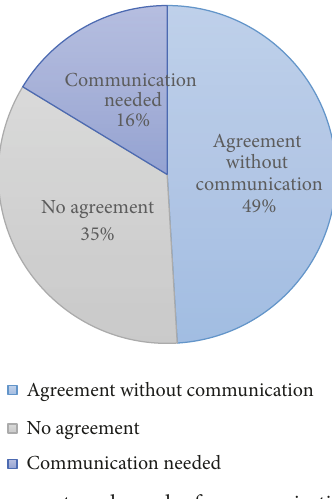
Figure 1: Agreement and need of communication to reach a diagnosis between oral and maxillofacial pathologist (OMFP) and oral and maxillofacial radiologist (OMFR).